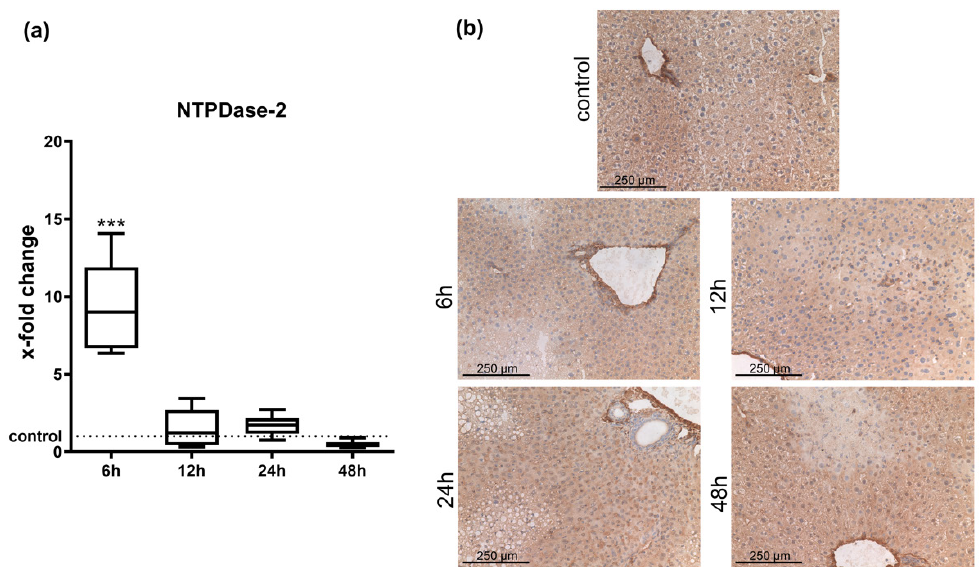
Figure 1. Ecto-nucleotidase triphosphate diphosphohydrolase-2 (NTPDase2) expression in wild type (WT) mice after acetaminophen (APAP) intoxication. ( a ) Entpd2 expression by qPCR in WT whole liver tissue relative to vehicle treated controls, ( b ) immunohistochemistry for NTPDase2 in WT liver tissue of NTPDase2 (brown) at different time points after APAP intoxication (200×) *** p < 0.001. ( n = 8 per time point).